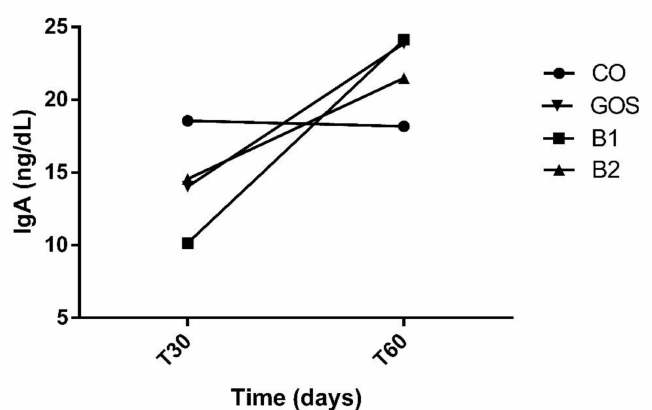
Figure 2. Increased fecal IgA at T60. Despite having no e ff ects, at T60, IgA increased in CO, GOS, and B1 treatments. CO: control food, without the addition of prebiotic; GOS: control food with addition of 0.38% galactooligosaccharides; B1: control food with addition of 0.5% YES GOLF ® prebiotic blend; B2: control food with the addition of 1% YES GOLF ® prebiotic blend; T30: 30-day period; T60: 60-day